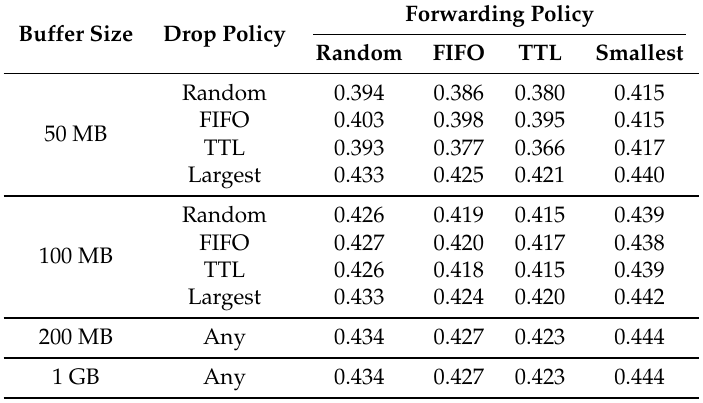
Figure 8. Delivery probability versus latency for a 12 and 24 h TTL (Time To Live) with different buffer sizes and queue policies. Table 2. Delivery probability for a 12 h TTL (Time to Live) with different buffer sizes and queue policies.